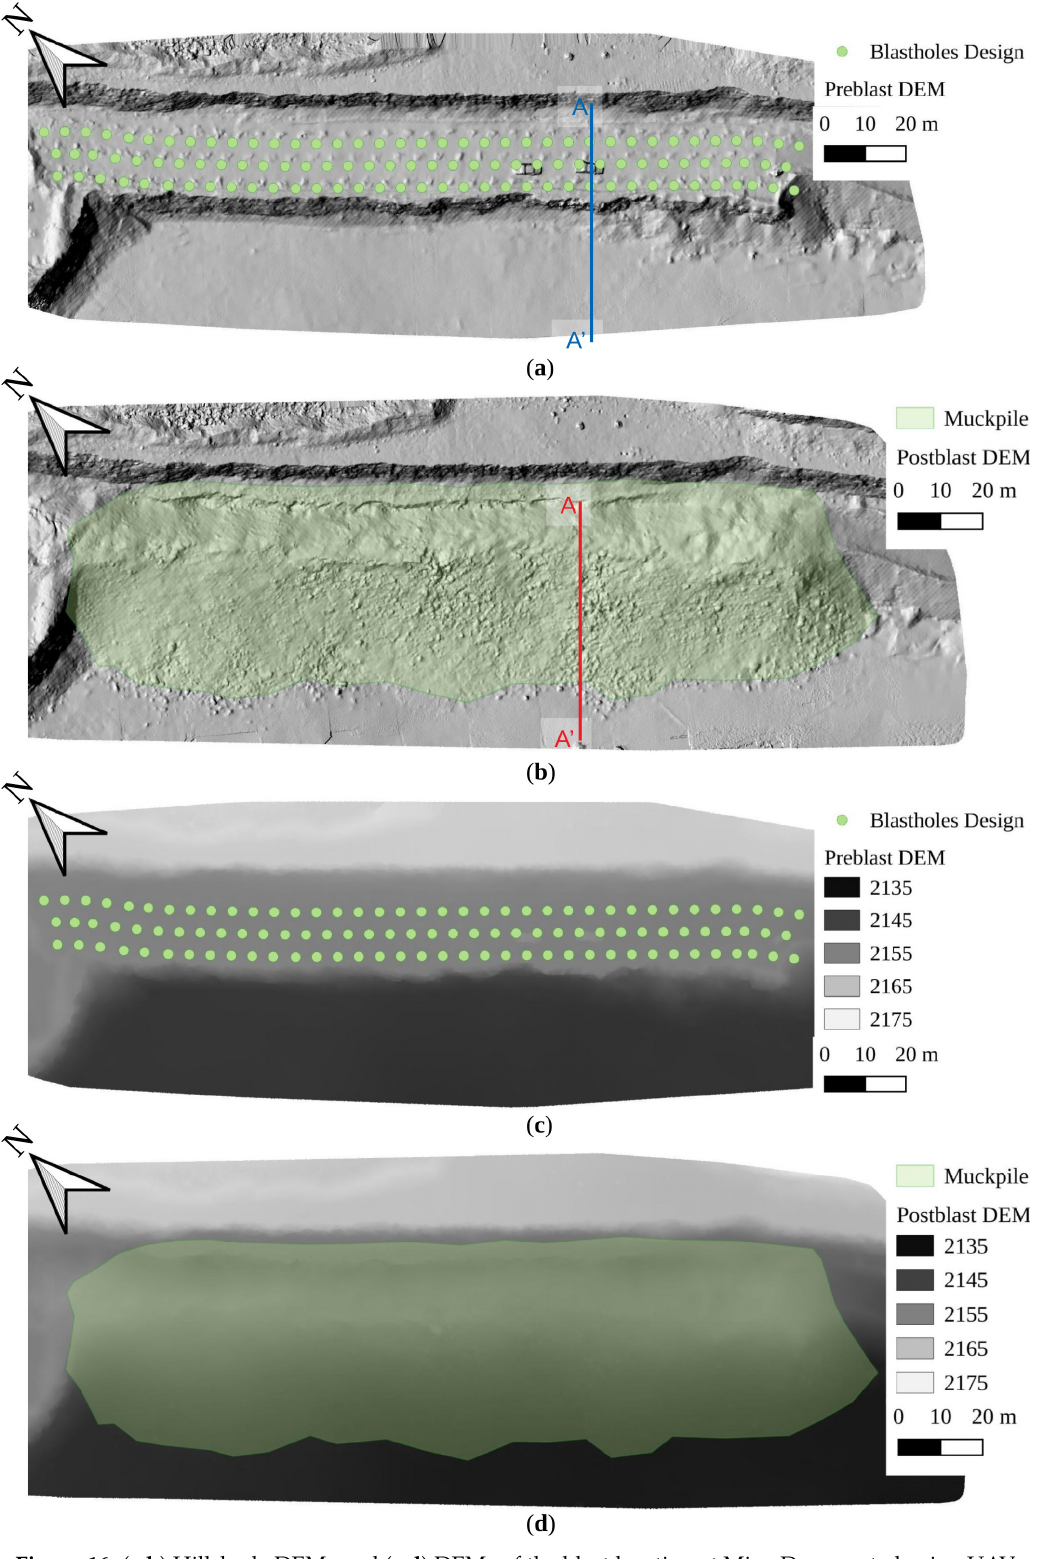
Figure 16. ( a , b ) Hillshade DEMs and ( c , d ) DEMs of the blast location at Mine D generated using UAV photogrammetry ( a , c ) before and ( b , d ) after the